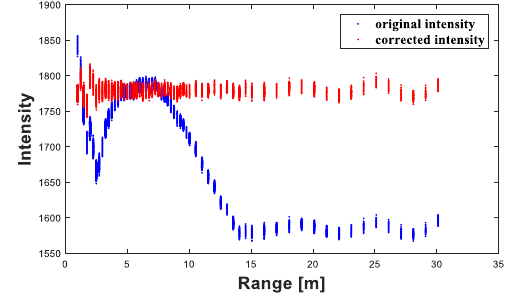
Figure 4. Original intensity data and intensity data after range